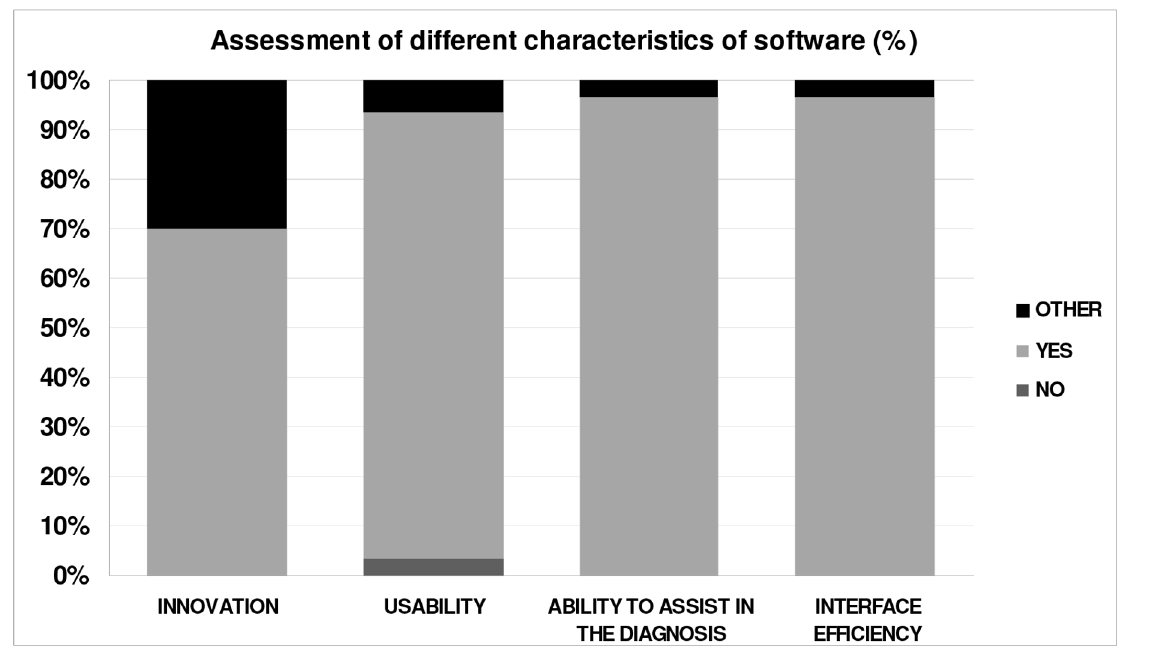
Fig 7. Assessment of different characteristics of software.